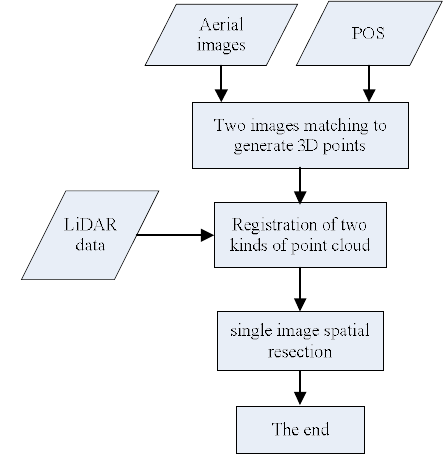
Figure 1. Data processing flow of one by